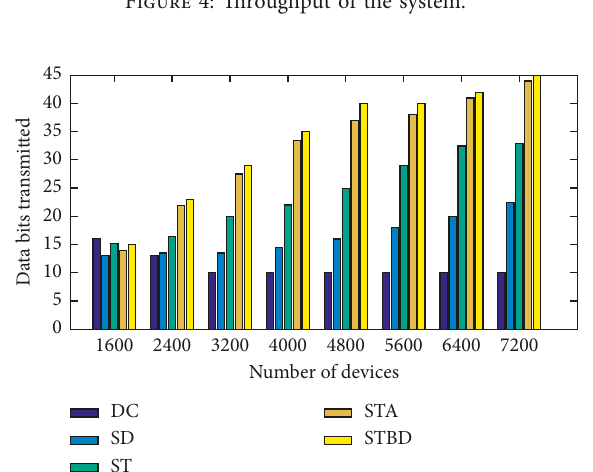
Figure 5: Number of requests from devices compared with number of served requests.